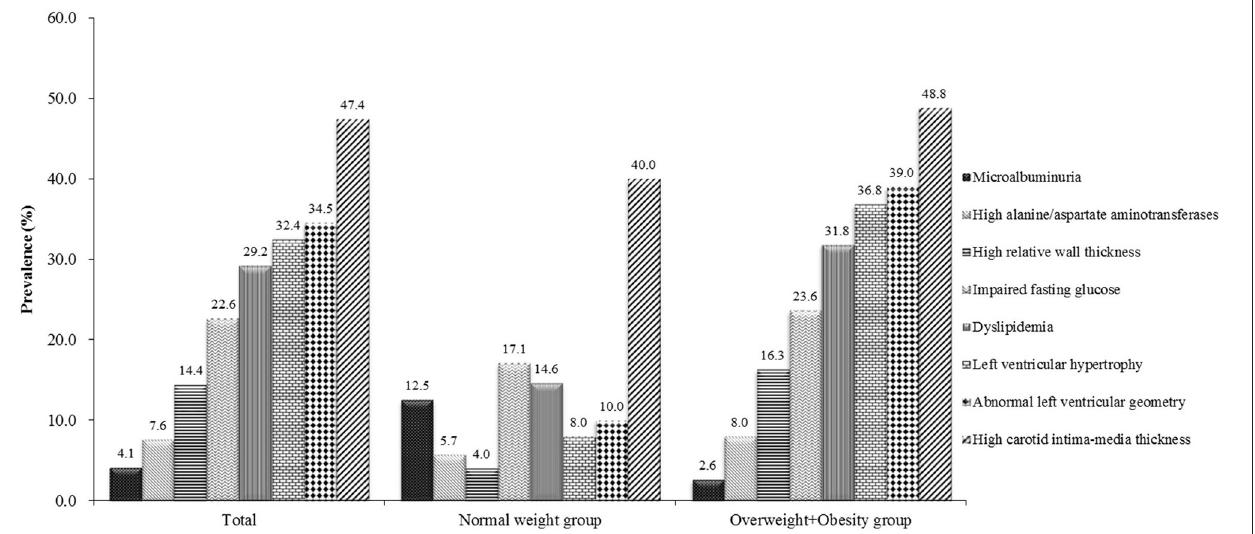
FIGURE 1 | Prevalence of target organ damage in Chinese hypertensive children and adolescents by weight